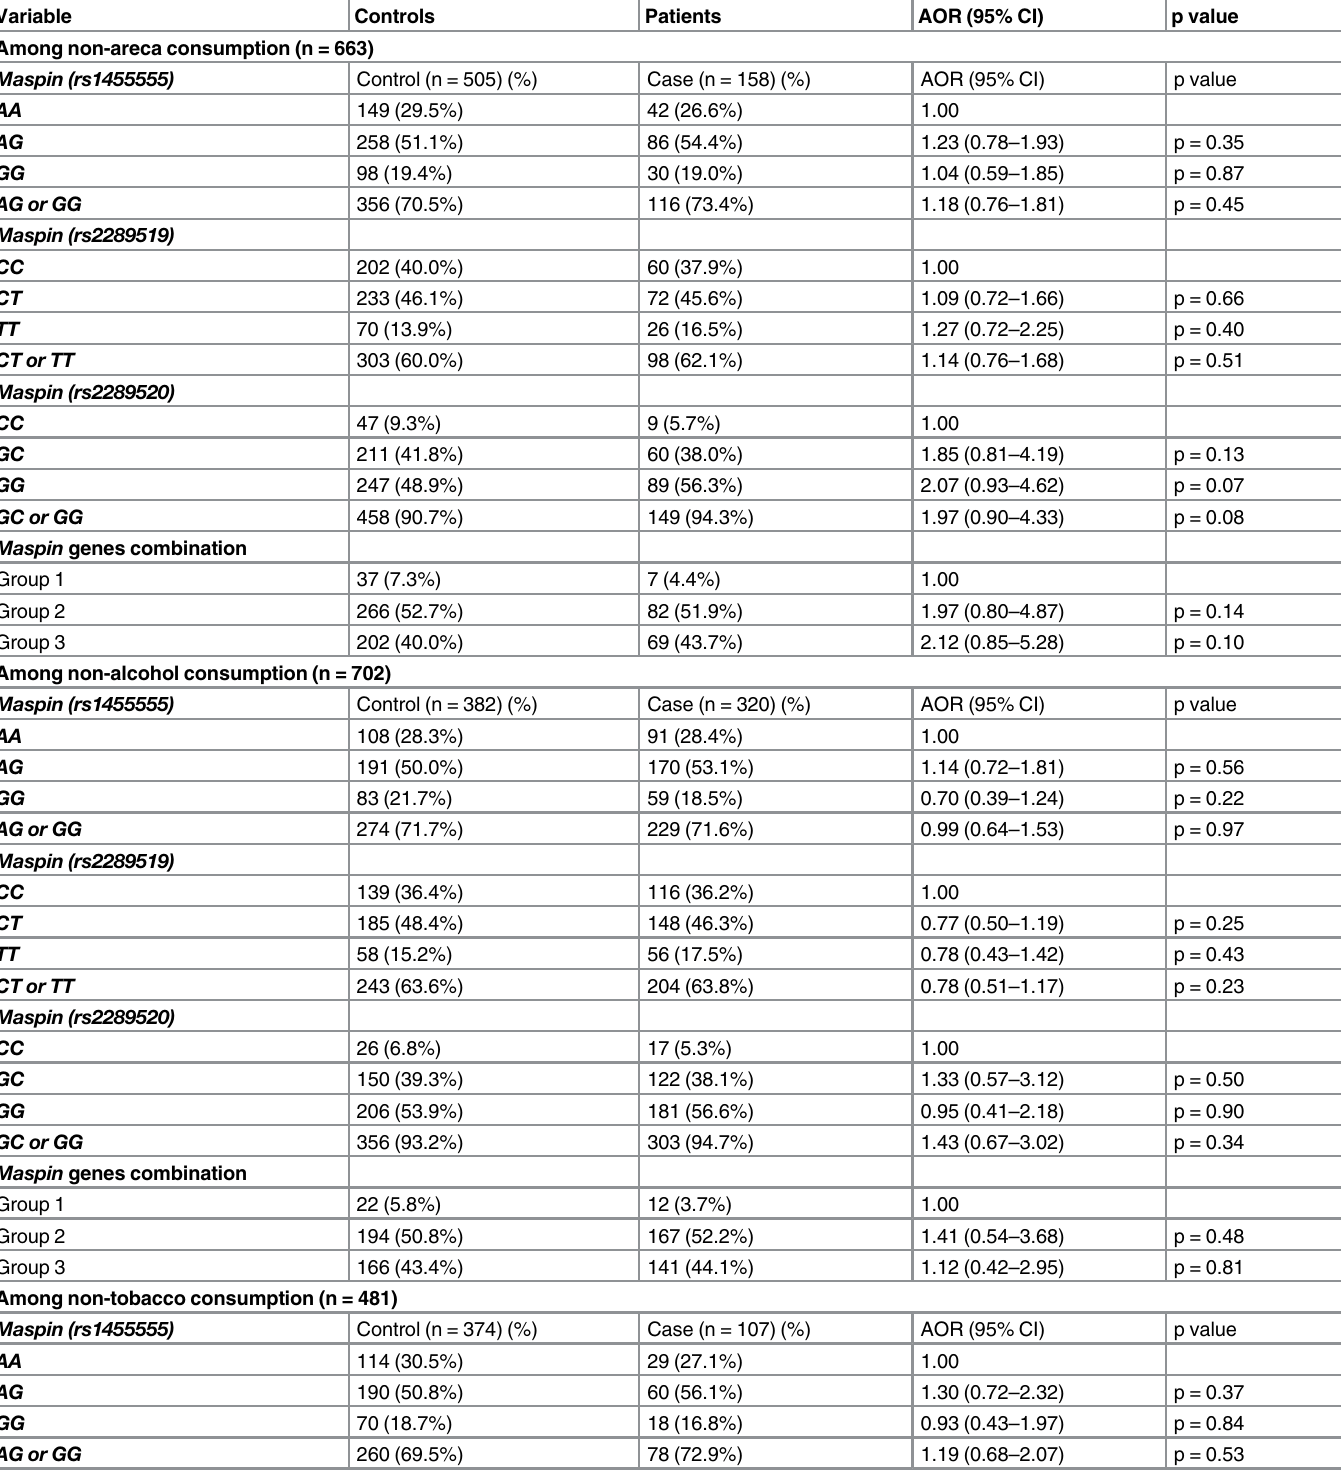
Table 3. Adjusted odds ratio (AOR) and 95% confidence intervals (CIs) of oral cancer associated with genotypic frequencies of Maspin among individuals non-exposure to related environmental risk